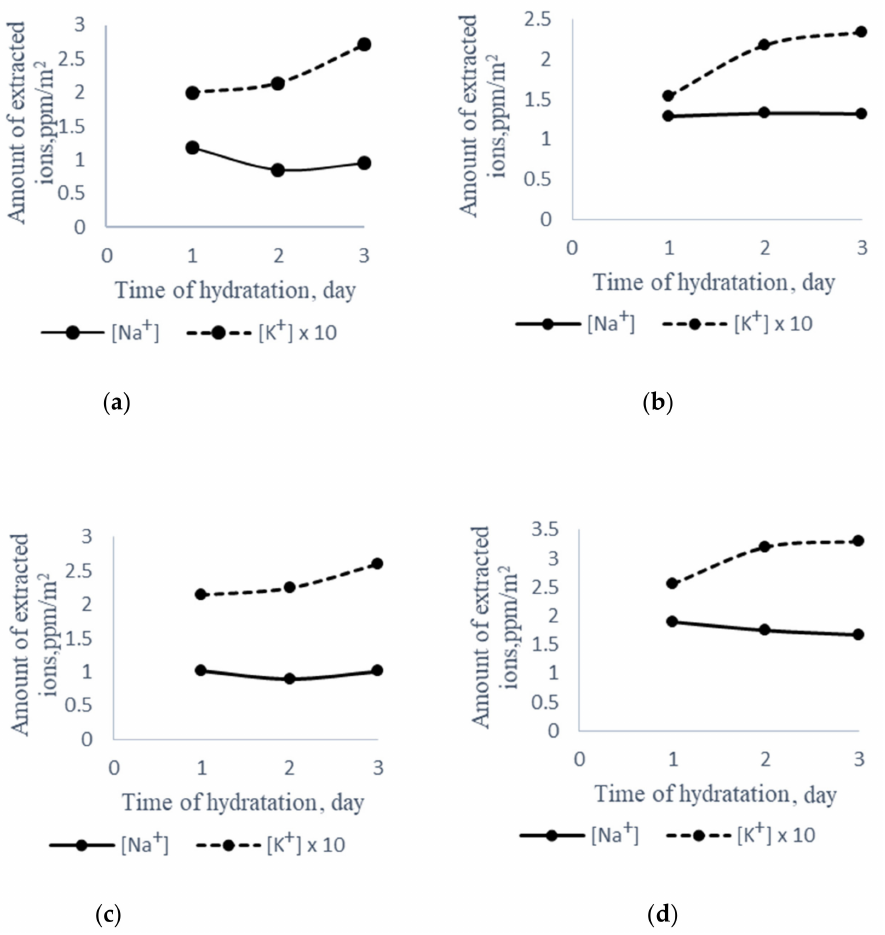
Figure 3. The amount of extracted ions from surface layers of the mortar vs. time of hydration of the cement: ( a ) 100% CEMI 32.5 R, ( b ) 90% CEMI 32.5 R + 10% colorless glass, ( c ) 90% CEMI 32.5 R + 10%